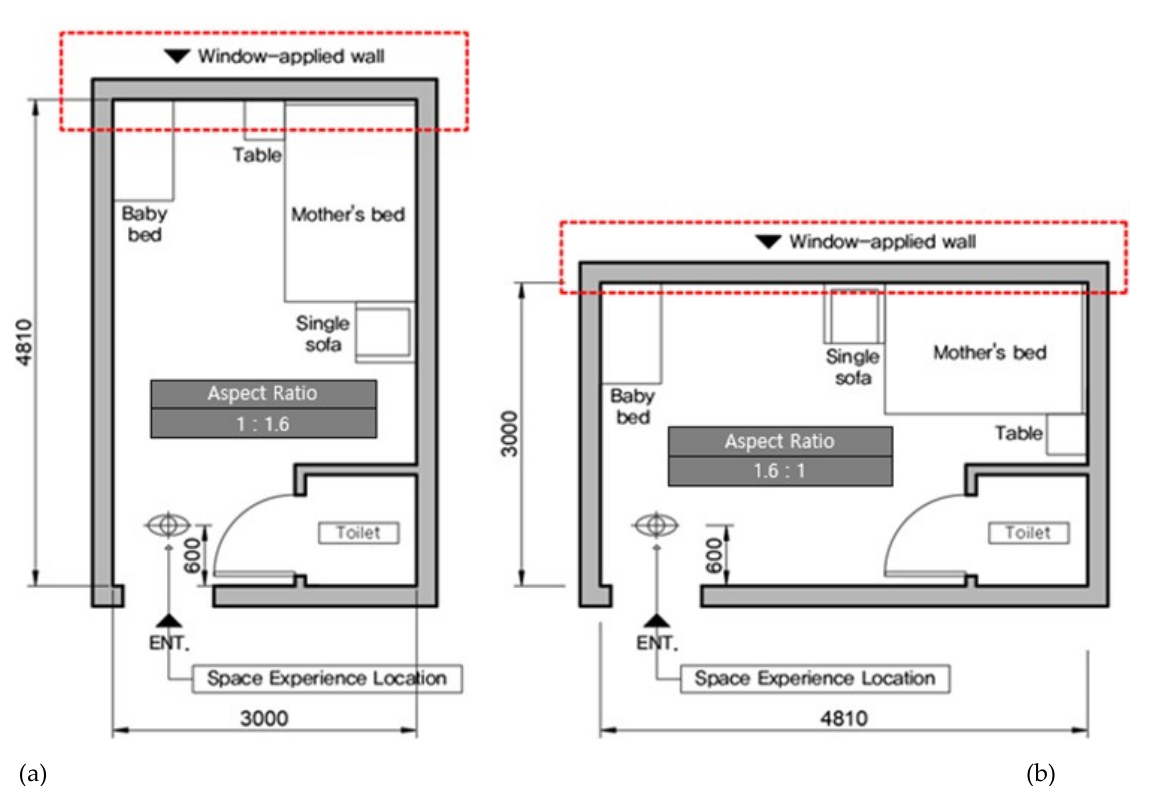
Figure 1. Floor Plan of space reproduced in virtual reality (VR). ( a ) Aspect ratio A type (1:1.6). ( b ) Aspect ratio B type (1:1.6). A change in the window area ratio was applied to the wall inside the red square box. The scene seen during the VR experience is the front when you enter the door. When measuring brain waves at this point, the head can be moved slowly from side to side to observe the space.